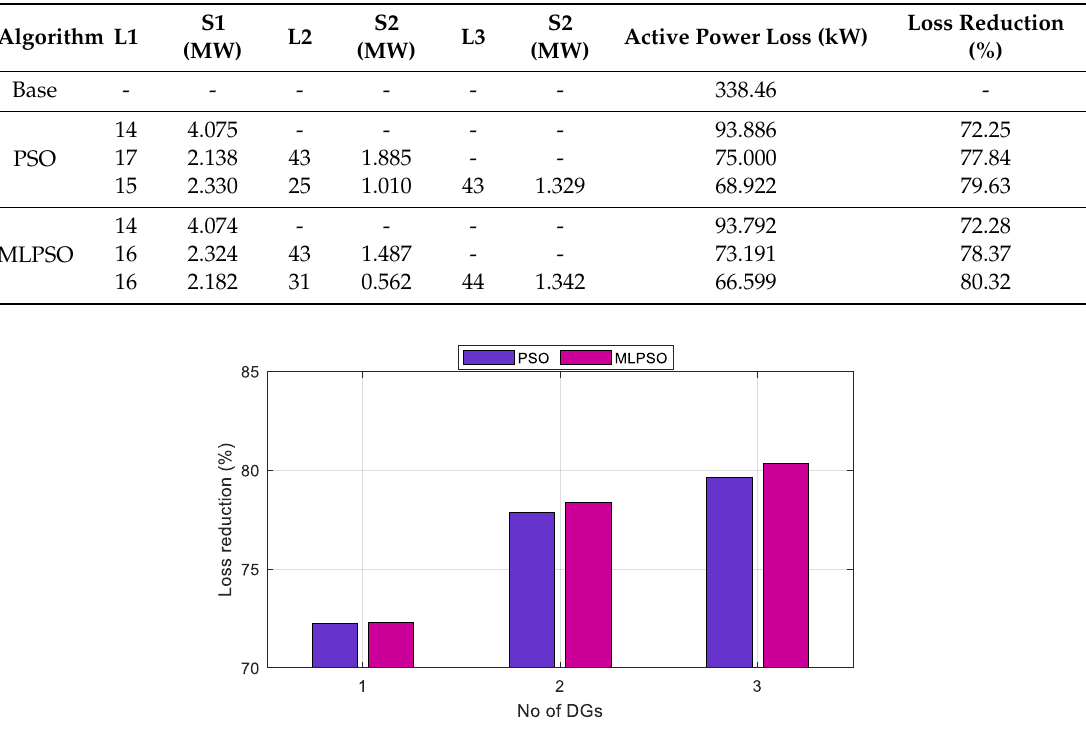
Figure 10. Variation of loss reduction with number of DGs for the Malaysian test system.